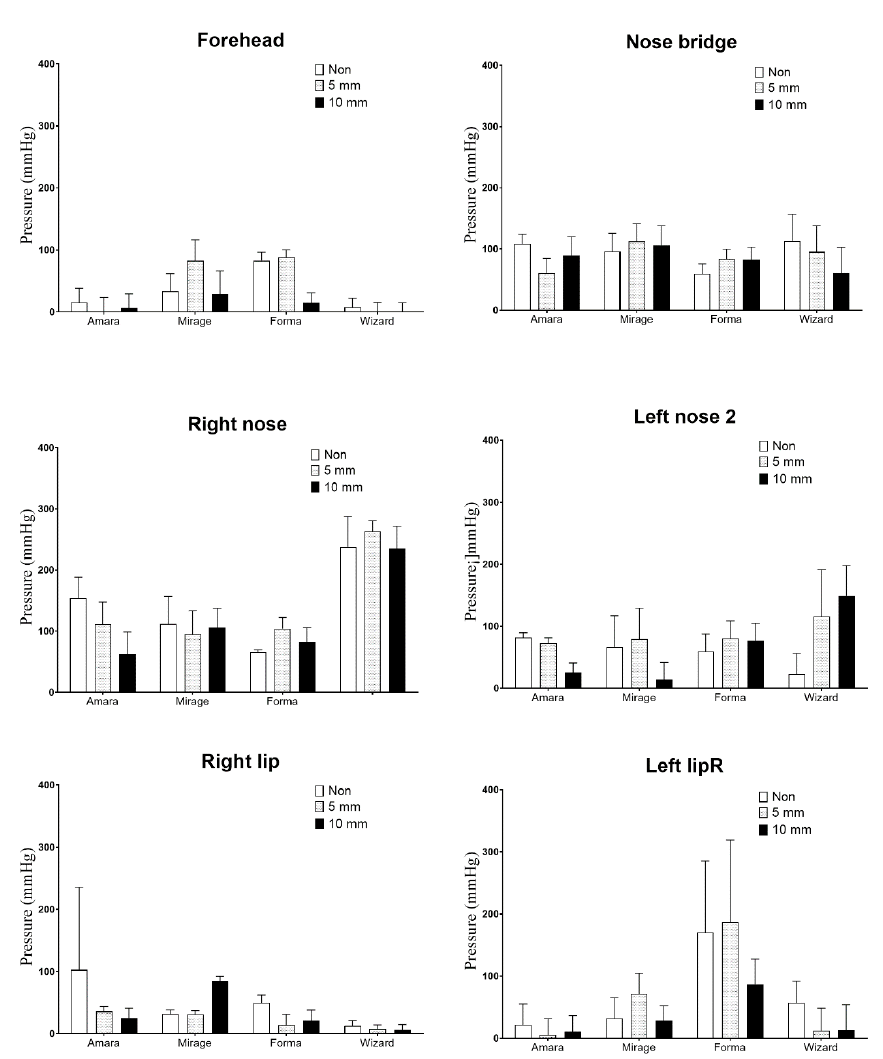
Figure 4. Pressure on each detection point from the four masks with and without a cushion. Healthcare 2020 , 8 , x